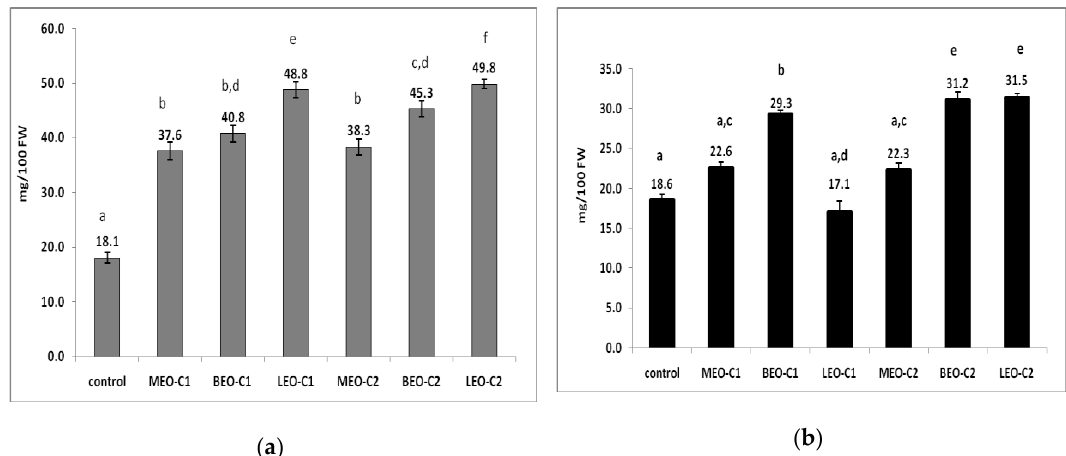
Figure 3. Levels of ascorbic acid in the peel ( a ) and pulp ( b ) of lemons after 7 days of storage in enriched air-space with EO vapor. Data represent means ± SD (mg AsA · 100 g FW). Di ff erent letters on top of column indicate di ff erences for p < 0.05, t -test. Vertical bars represent standard deviations for n = 10; MEO-C1 = 183 µ L · L − 1 , BEO-C1 = 46 µ L · L − 1 , LEO-C1 = 86 µ L · L − 1 , MEO–C2 = 91.5 µ L · L − 1 , BEO-C2 = 23.0 µ L · L − 1 , LEO-C2 = 43.0 µ L · L − 1 .